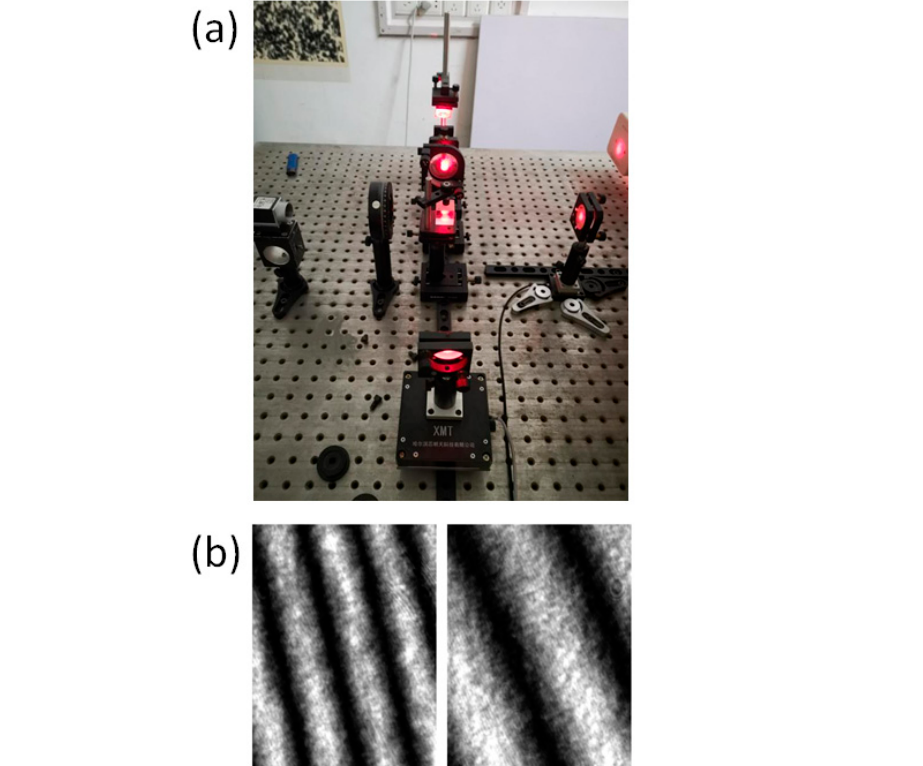
Figure 9. The schematic drawing of the measurement system.